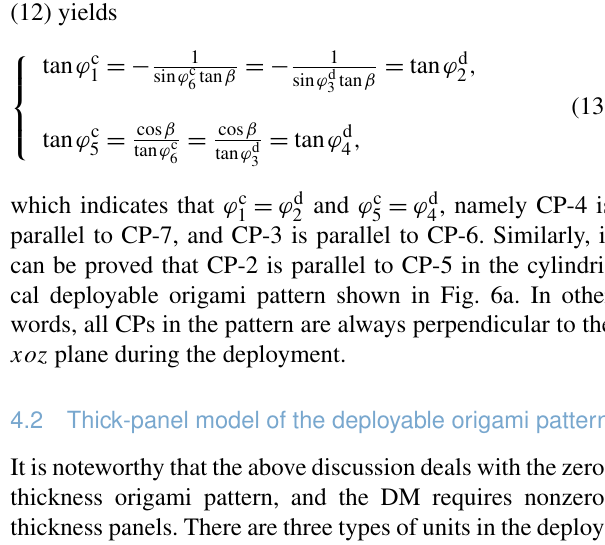
and ϕ c in U B -C, where ϕ b 7 45